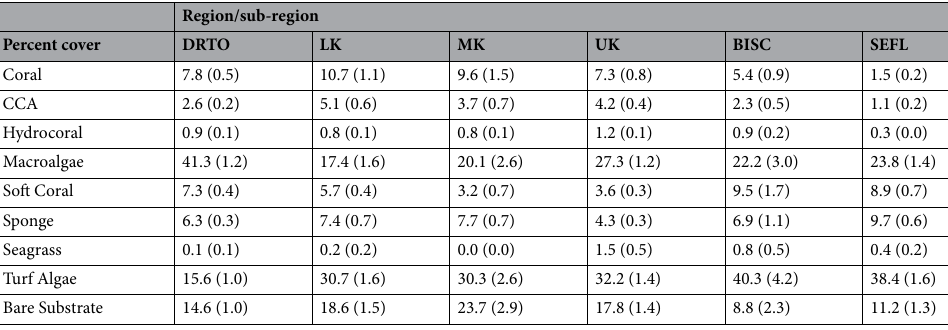
Table 1. A regional/sub-regional comparison of average percent cover of organisms recorded along benthic surveys. Regions/sub-regions are listed in a southern to northern gradient as follows: DRTO Dry Tortugas; LK Lower Keys; MK Middle Keys; UK Upper Keys; BISC Biscayne; and SEFL Southeast Florida. Std. error is listed in parentheses.